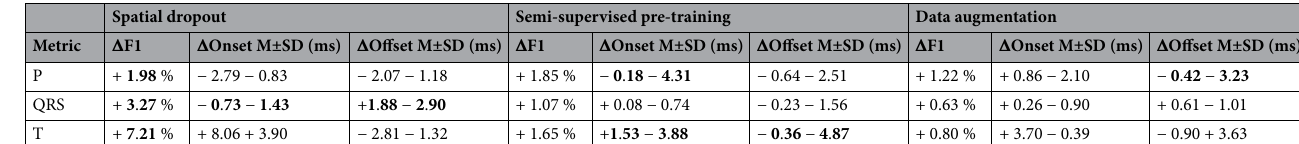
Table 1. Performance gain comparisons of design decisions, expressed as median difference values in F1 score (%), onset and offset error (ms). A positive F1 score indicates a performance increase of the design decision, whereas negative onset/offset mean or STD errors indicate more precise fiducial location. Bold values represent best independently performing approaches.